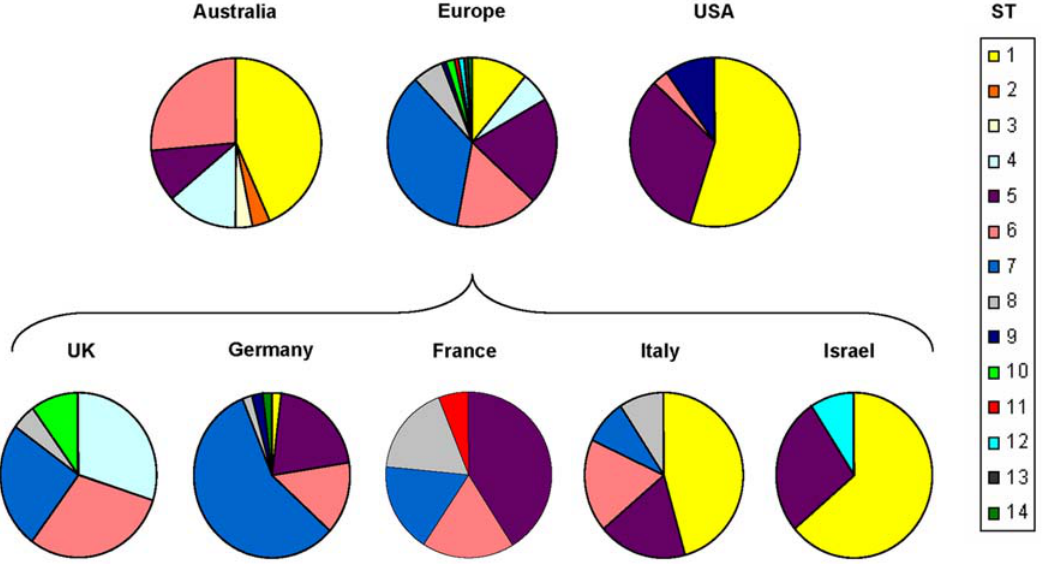
Figure 1. Geographical distribution of B.henselaeSTs in different continents. The lower panel shows the ST distribution in European countries that were represented by at least 10 isolates.